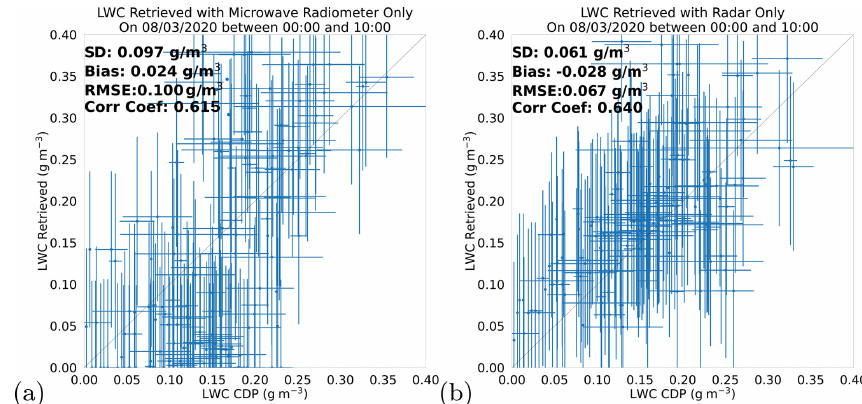
Figure 11. Scatter plots of the liquid water content retrieved versus the liquid water content observed through with in situ sensor. Panels (a) and (b) respectively refer to 1D-Var retrievals run with only the microwave radiometer and only the cloud radar, with both using the nearest background profiles and a full fog B matrix with cross-correlations between variables. Error bars on the x axis indicate the range of in situ observations recorded throughout the height level corresponding to the retrieval height levels at the time of comparison. Error bars on the y axis were estimates of retrievals found from the square root of diagonal elements of the analysis error covariance matrix. The scatter plots show comparisons for all retrieval height levels between 37 and